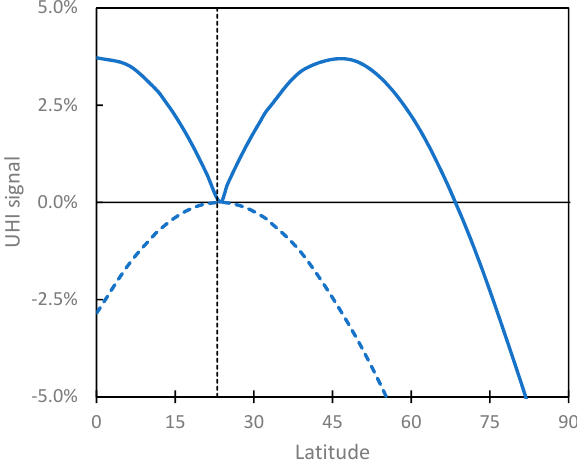
Figure 4. Irradiance balance or UHI signal for PV facades for the scenarios with a bright road (solid line) and a dark road (dashed line) as a function of latitude for α r = 30%; α PV = 10%; α w = 70%; α g = 30% (bright road) or α g = 0% (dark road). The dotted vertical line indicates φ = 23. PV efficiency assumed: 20%.